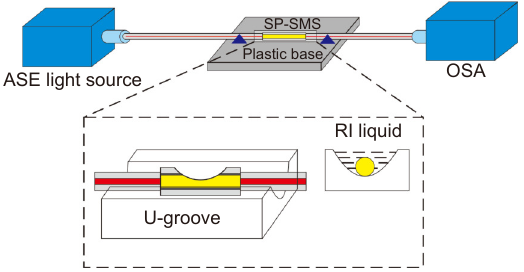
Fig. 6 | Schematic of experimental setup for polishing